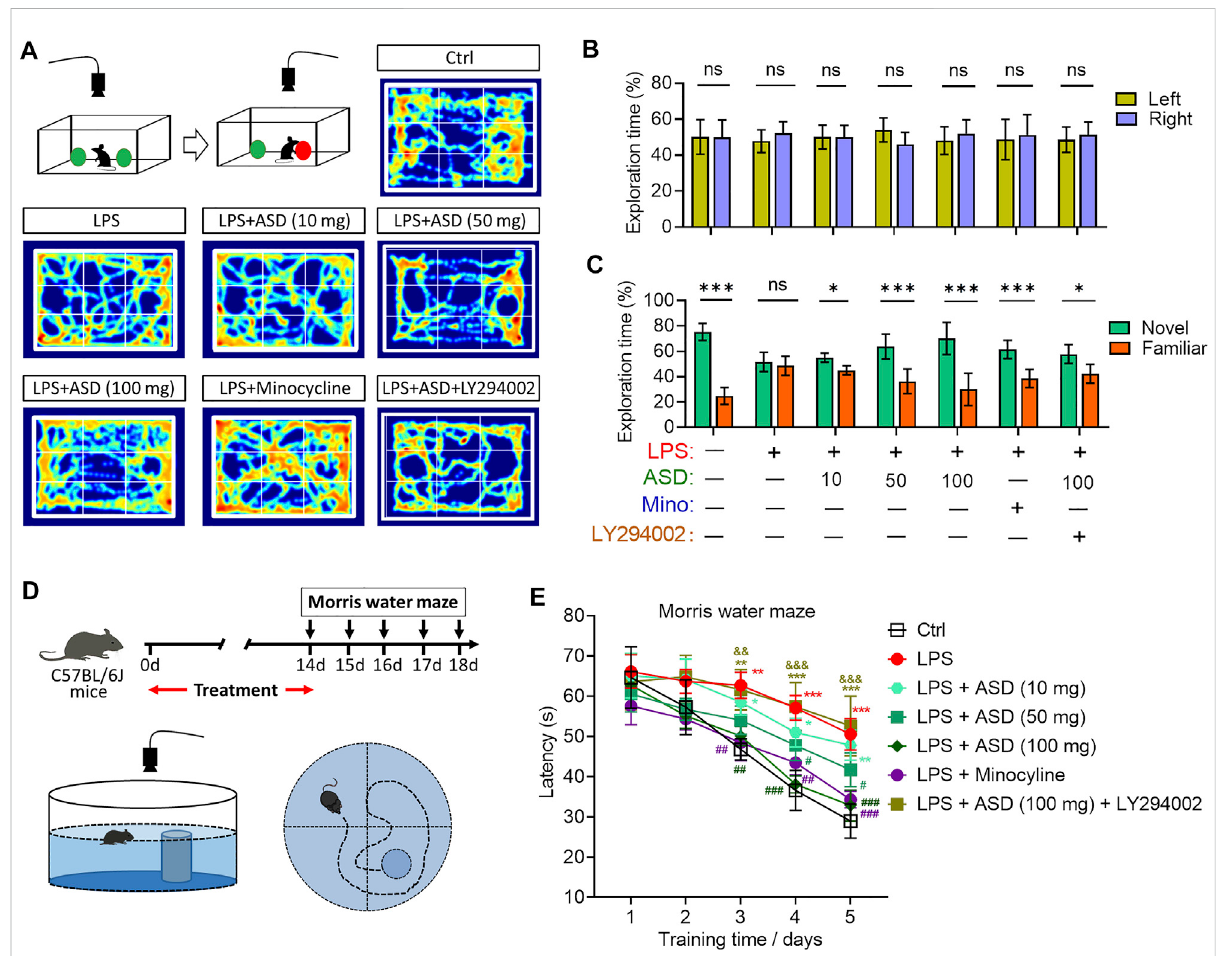
FIGURE 10 Effects of ASD on cognitive impairment of mice chronically exposed to LPS in the presence or absence of PI3K-Akt inhibitor. (A) , Scheme describingtheexperimentalevaluationofmiceusingthenovelobjectrecognitiontest,andheatmapofmousebehaviorinthistest. (B) ,Miceshowed a preference for the novel item, regardless of whether it replaced the familiar object on the right or left. (C) , Comparison of preference for the novel or familiar object. (D) , Scheme describing the experimental evaluation of learning and memory using the Morris water maze test. (E) , Morris water maze latency of mice treated with saline (Ctrl) or lipopolysaccharide (LPS), followed by akebia saponin D (ASD), minocycline or PI3K-Akt inhibitor(LY294002).Dataaremean±standarderrorofthemean(SEM)(n=8-11).Panels(B)and(C):* p < 0.05,*** p <